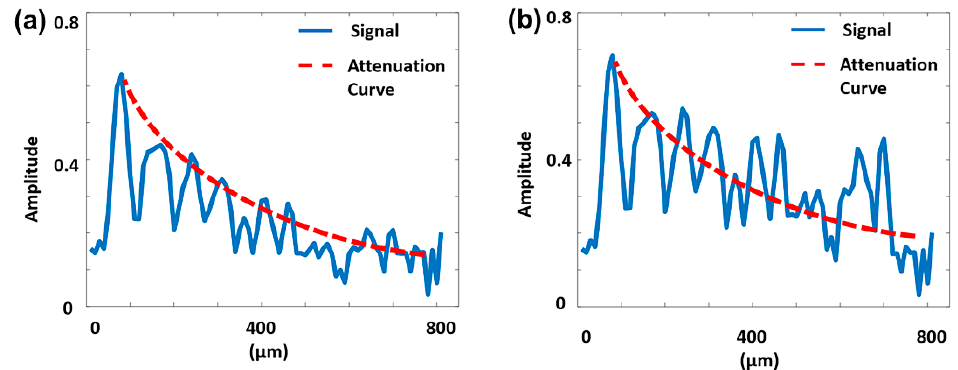
Figure 2. Photoacoustic A-scan signal. ( a ) Typical full bandwidth signal with an assumed signal attenuation function (red dashed curve) and ( b ) corrected A-scan signal by normalizing using the exponent of Equation (3).